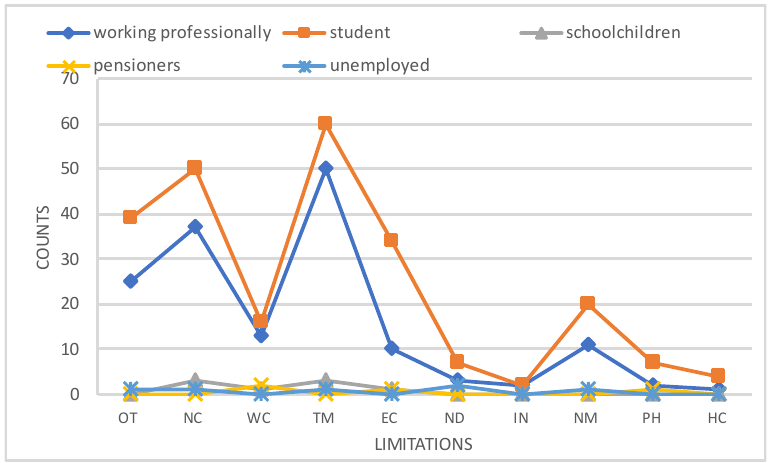
Figure 24. Graph of the interaction between the limitations in the availability of the bus and occupation.